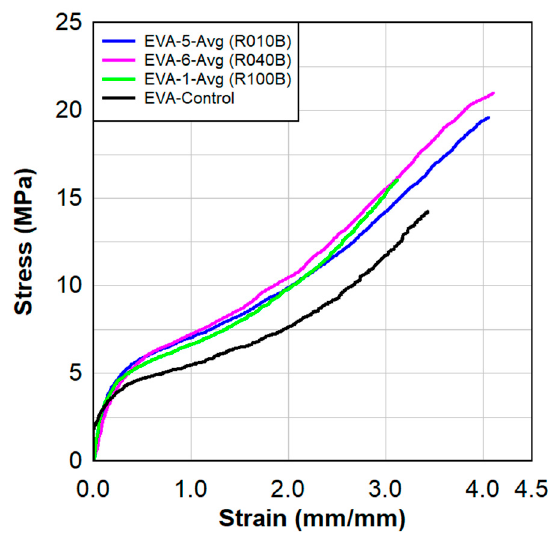
Figure 18. Radiation dose e ff ect on the tensile strength of EVA.